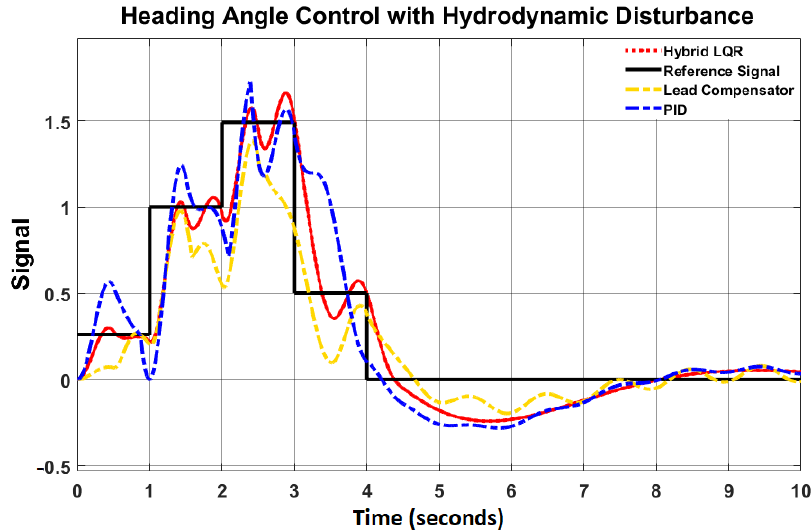
Figure 14. Heading angle control system with hydrodynamic